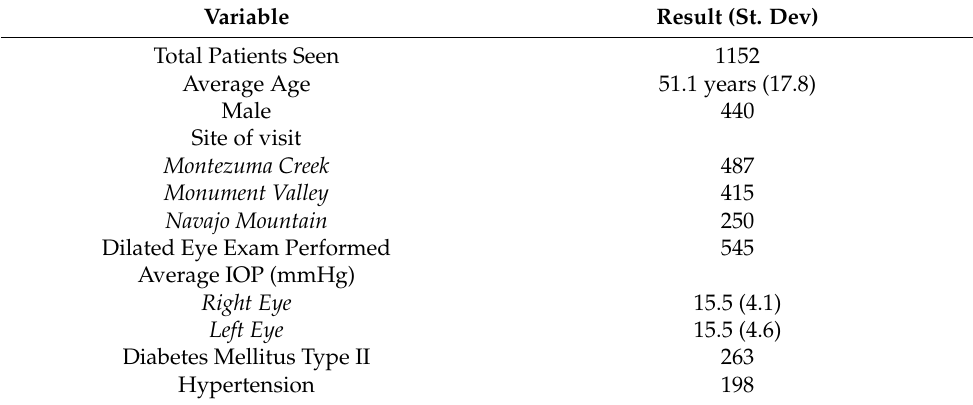
Table 1. Descriptive Summary of all Study